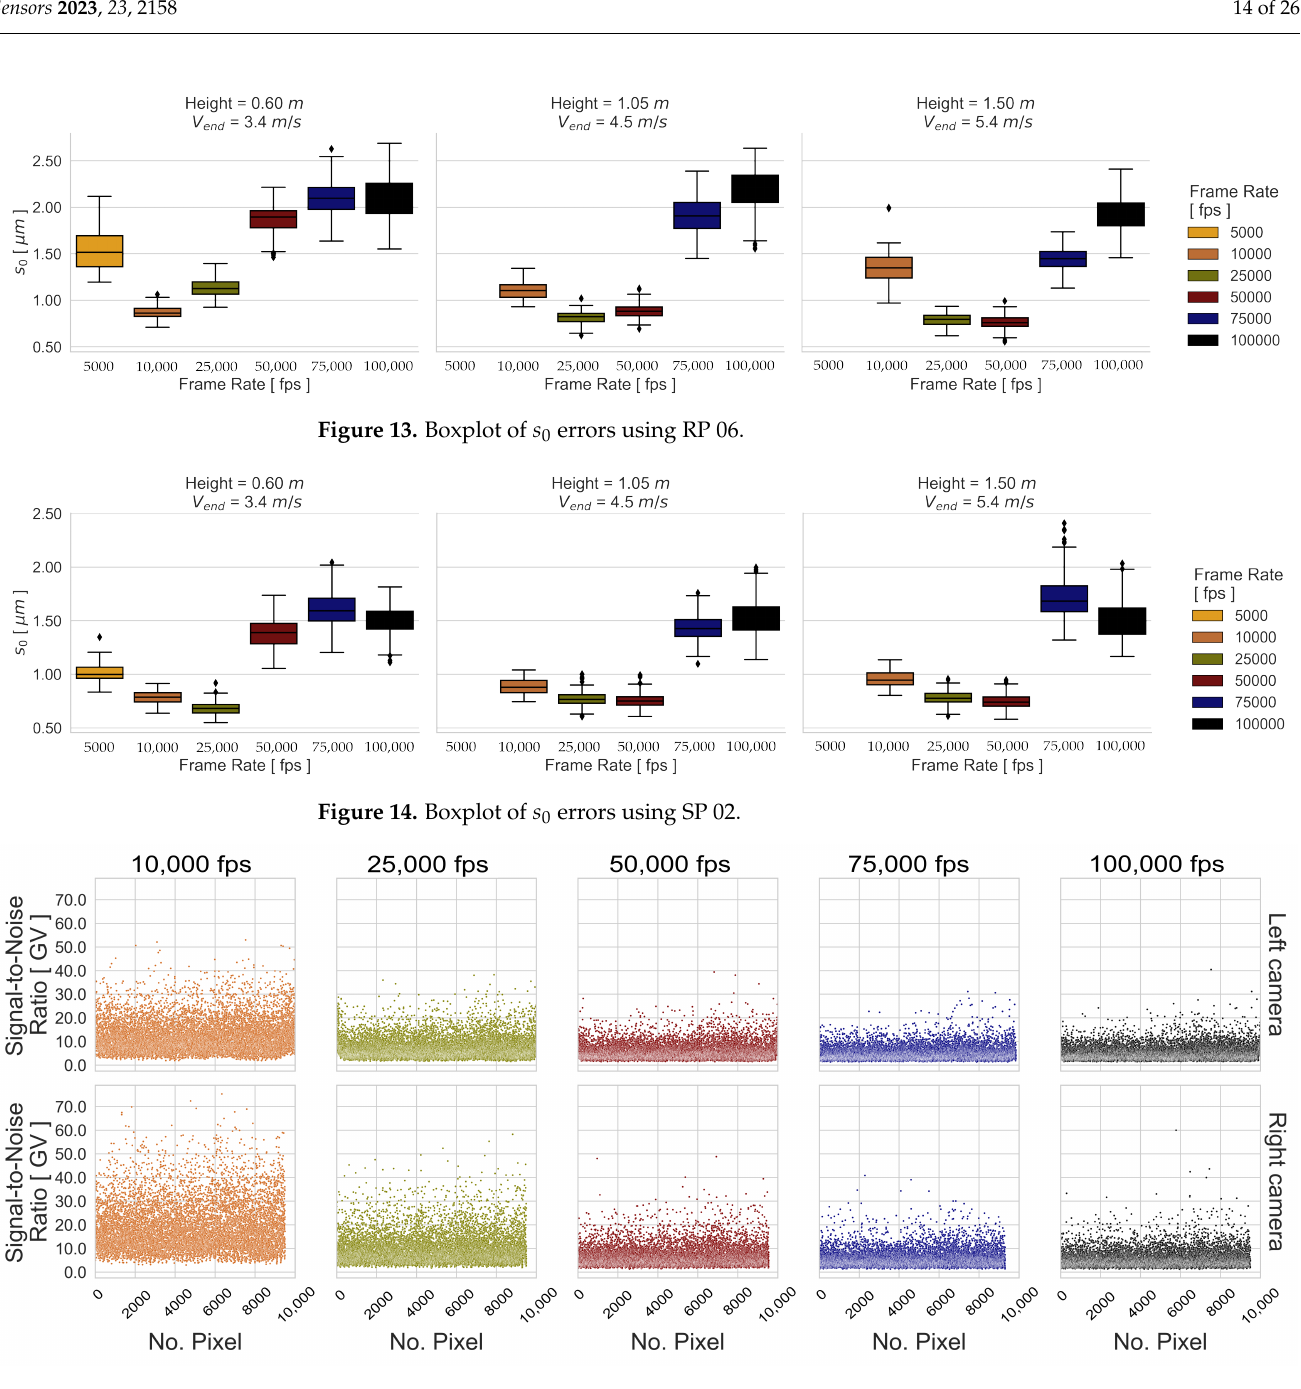
Figure 15. Signal-to-noise ratio per pattern image pixel ( SNR P exposure times at the 03